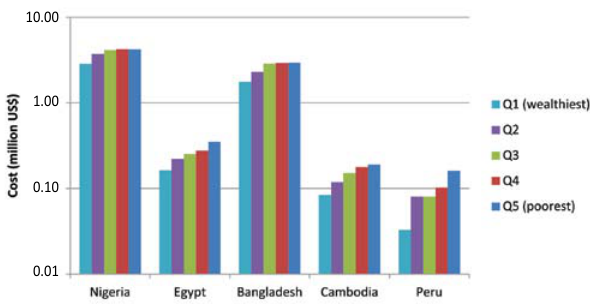
Figure 7 Cost of community case management (CCM) treatment by wealth quintile in exemplar countries.